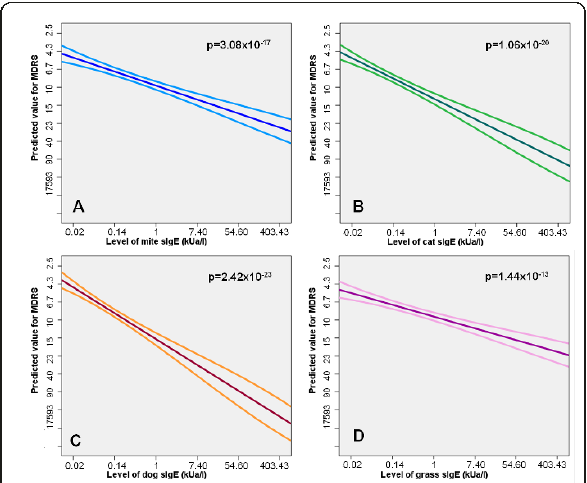
Figure 3 Predicted value for MDRS in relation to sensitization to mite (A), cat (B), dog (C) and grass pollen (D) - sIgE level (kU A /l), derived from the linear regression analysis (regression line with 95% CI) . Note : analysis done with tMDRS (= 100/(MDRS +10), with converted values shown in Y axis, hence inverted scale.